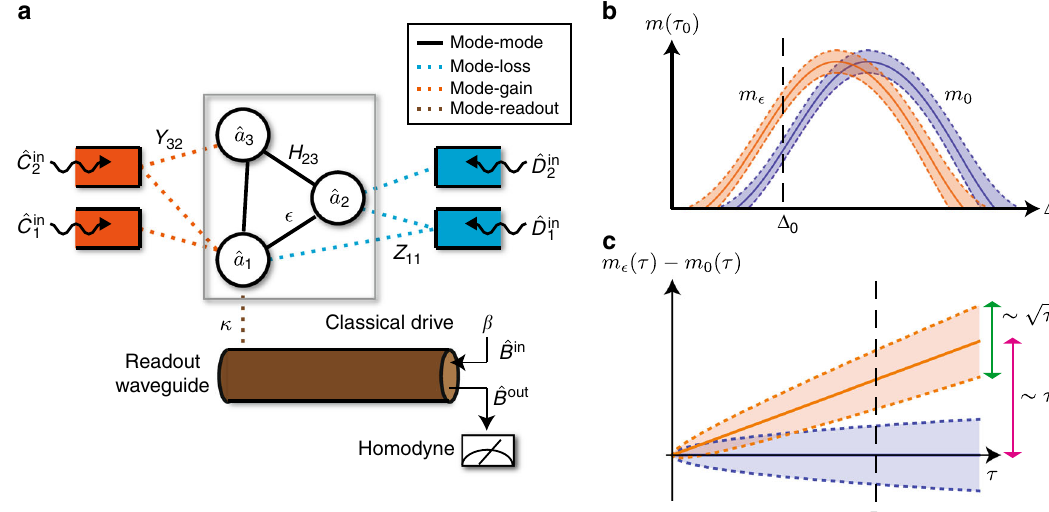
Fig. 1 General dispersive measurement setup and measurement results. a The setup consists of resonant modes (circles) that interact via a parameter- dependent non-Hermitian Hamiltonian. Standard analyses only consider the non-Hermitian dynamics of mode amplitude (region inside gray rectangle). In this work, we instead treat the system as an open quantum system, where non-Hermitian dynamics is generated by coupling to gain/loss baths (red/blue rectangles) and a readout waveguide. The operators and parameters are de fi ned in Eq. (5). Particularly, the coupling rates to the various baths (dotted lines) is characterized by matrices Y and Z , and H describes the Hermitian direct couplings between modes (solid lines). A classical drive is injected into the readout waveguide, which couples only to mode 1. Its re fl ected fi eld is measured by homodyne detection. A parametric change in the Hamiltonian (e.g., coupling between modes 1 and 2 here) changes the state of modes as well as that of the re fl ected fi eld. b Integrated homodyne current m at a certain measurement time τ 0 , as a function of the detuning Δ of the drive frequency from the cavity 1 resonance frequency. The shaded area denotes uncertainty due to measurement noise, and the two curves are for two values of the parameter to be sensed. A parametric change can be optimally detected by measuring at a single detuning, e.g., Δ 0 (dashed vertical line). c Time variation of integrated homodyne current for a fi xed detuning Δ 0 . The signal induced ffiffiffiffiffi Np ffiffiffiffi ffiffiffi p τ p . Therefore, any by the perturbation to be sensed ( , pink arrow) scales linearly as τ , while the uncertainty ( , green arrow) has a weaker scaling, S small perturbation can be resolved for suf fi ciently long